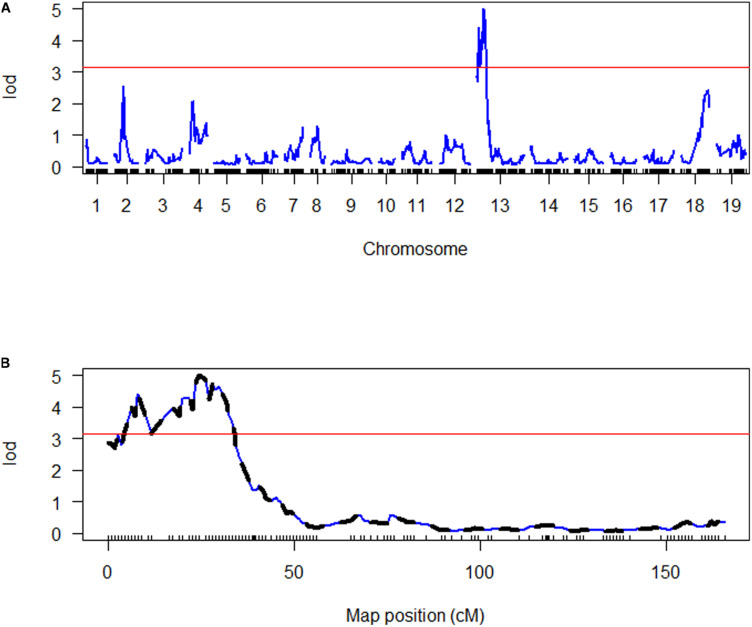
Genome scan of LOD scores for the number of resting spores per plant. (A) The LOD scores estimated by simple interval mapping (SIM). (B) The LOD scores for the chromosome C03 where one QTL was identified (C03 = chromosome 13); the LOD scores estimated by multiple QTL mapping are indicated in black, while the LOD scores estimated by SIM are indicated in blue. The red line represents the LOD threshold determined by 1000 permutations.